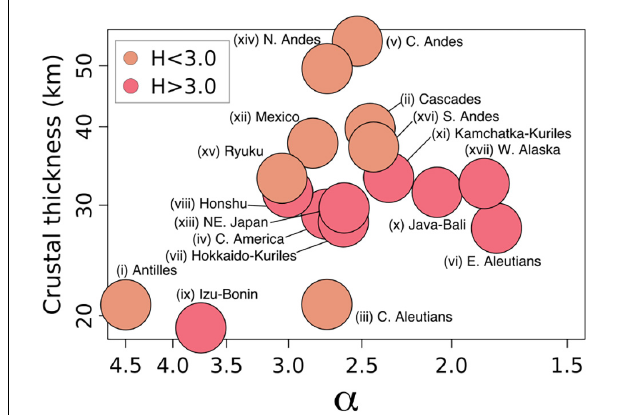
FIGURE 8 | The distribution of the power-law slope parameter ( α ) versus the mean average crustal thickness (Z) for each arc. Volcanic arcs are distinguished into two regimes according to the age of the slab and subduction motion (Eq. 2). Note that the α parameter decreases to the right. Hence, the median size of volcanic eruptions increases to the right.